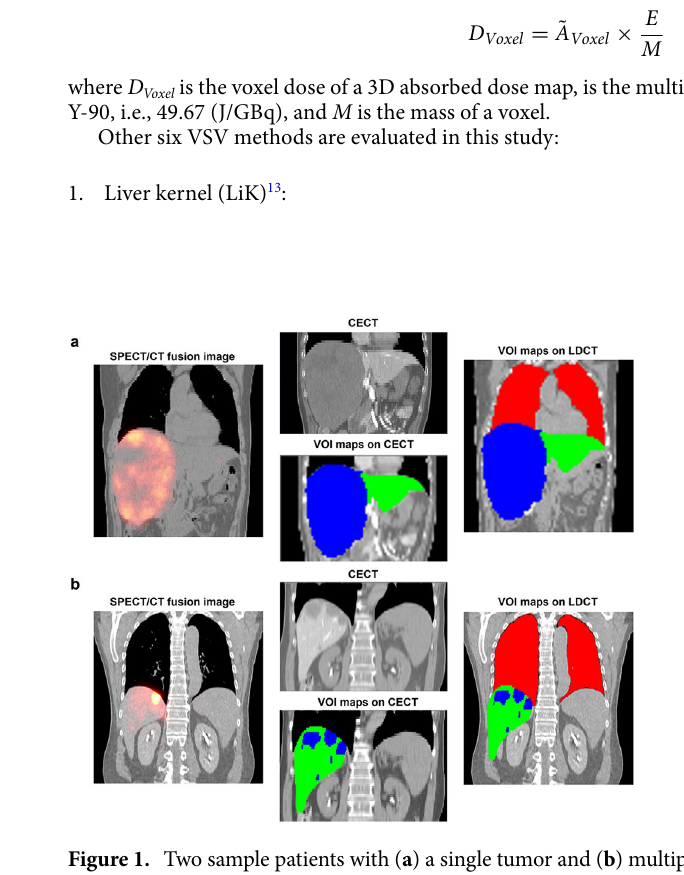
Figure 1. Two sample patients with ( a ) a single tumor and ( b ) multiple tumors. Red: lungs, blue: tumors, green: